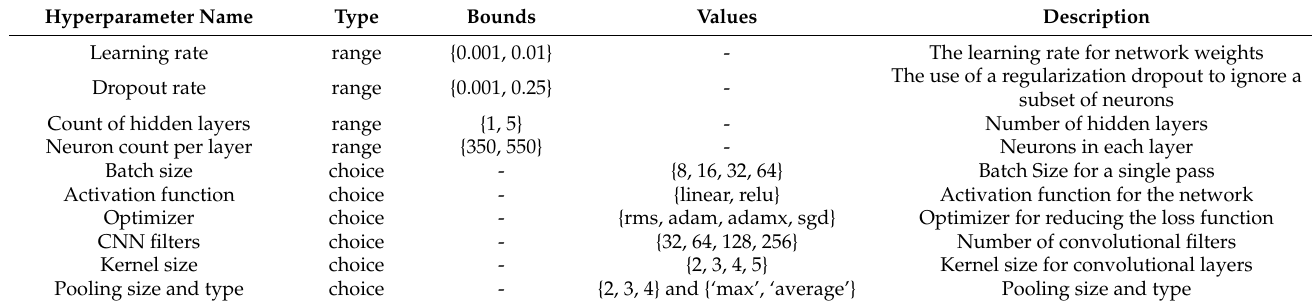
Table A1. Search space configuration for hyperparameter optimization for both